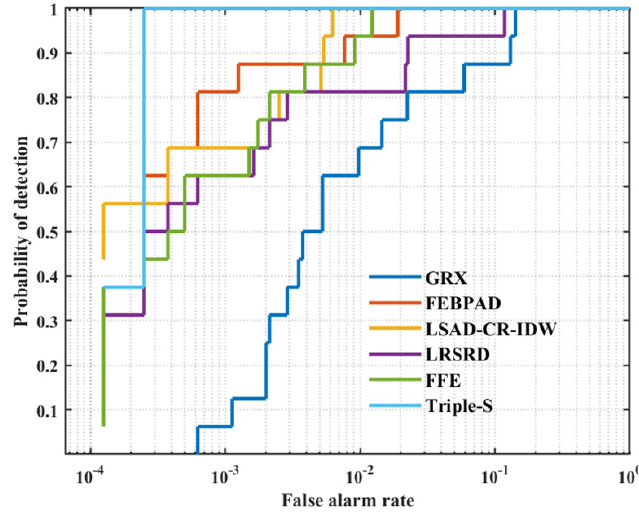
Figure 8. Receiver operating characteristic (ROC) curves for HYDICE Urban dataset.